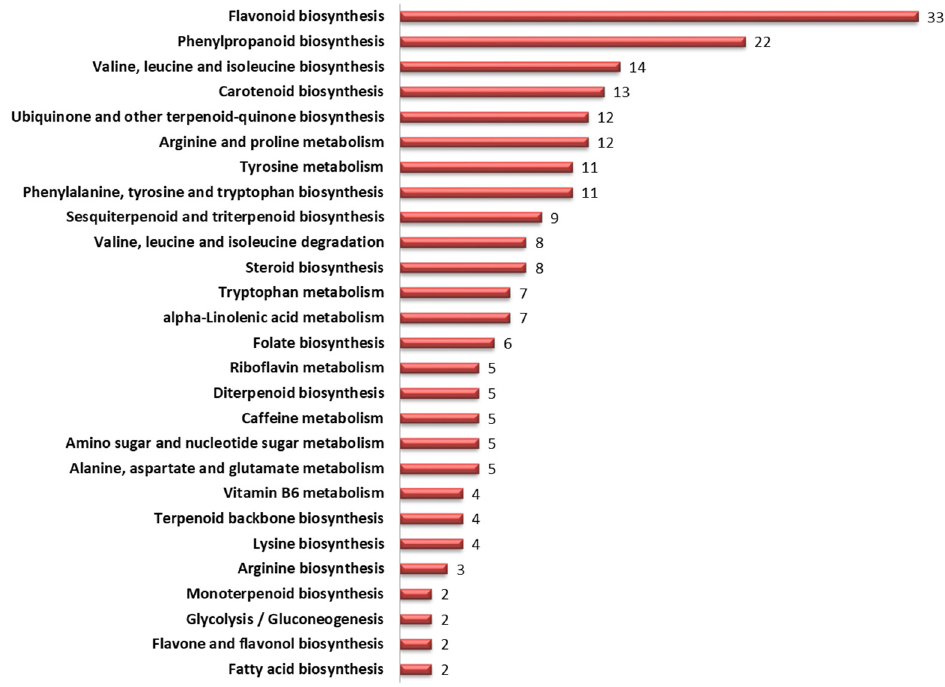
Figure 3. Mapping of sorghum grain metabolites onto KEGG (Kyoto Encyclopaedia of Genes and Genomes) metabolic pathways. Values indicates the number of metabolites mapped against various specific pathways.